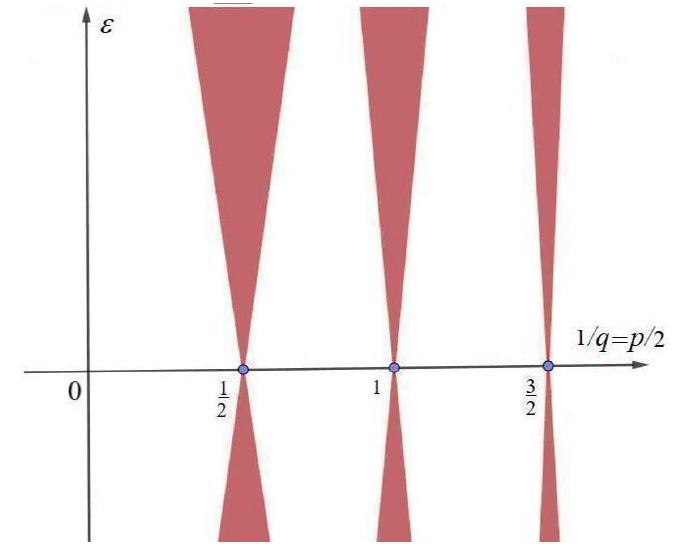
Figure 2. Instability red domain in the parametric resonance case (from [18], pp. 195–200, Figure